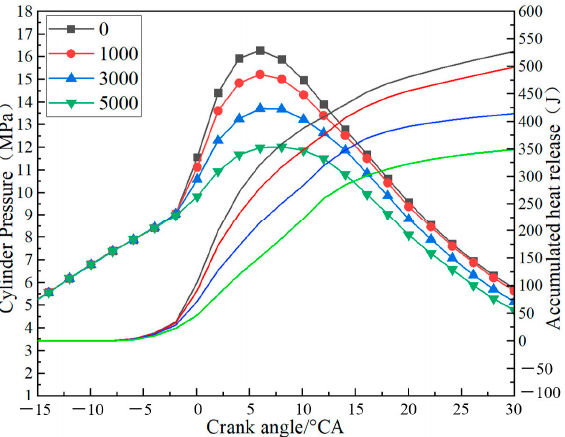
Figure 15. Variation of combustion pressure in cylinder with altitude.